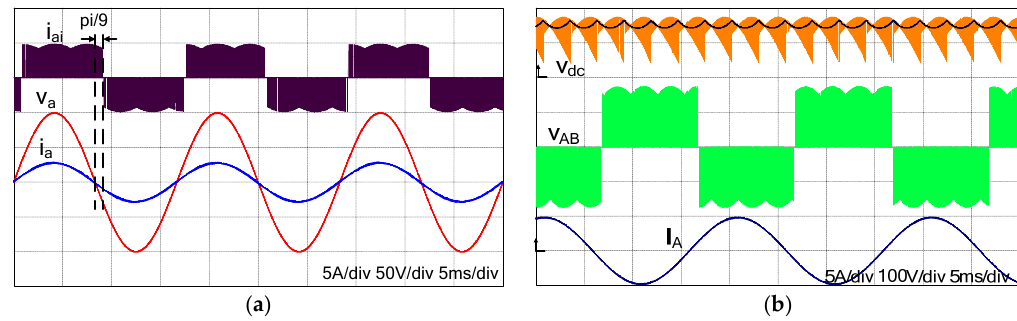
Figure 9. ( a ) Input waveforms; and ( b ) DC ‐ link voltage and output waveforms with the proposed method at m = 0.6 and f out = 50 Hz.